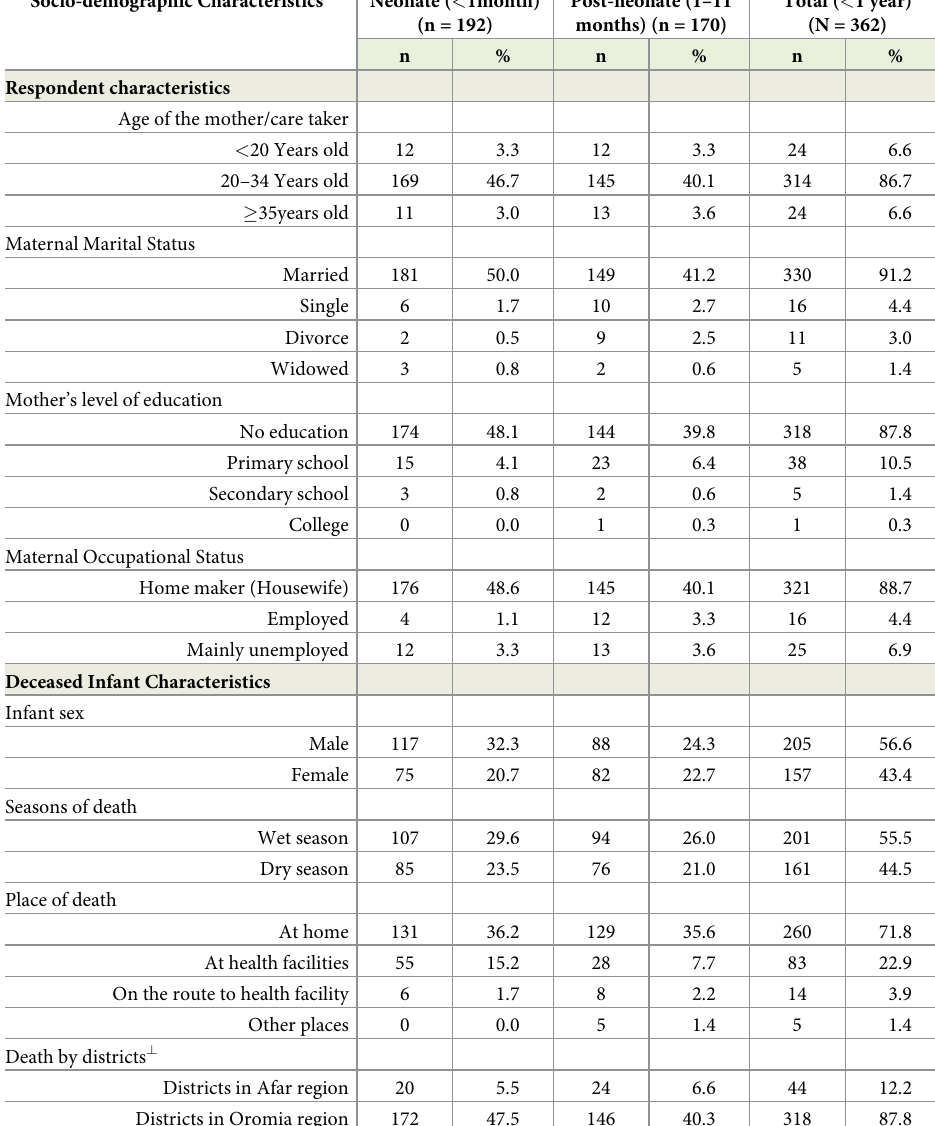
Table 1. Frequency distribution of the respondents and the deceased infant characteristics in Eastern Ethiopia, 2016–18. Socio-demographic